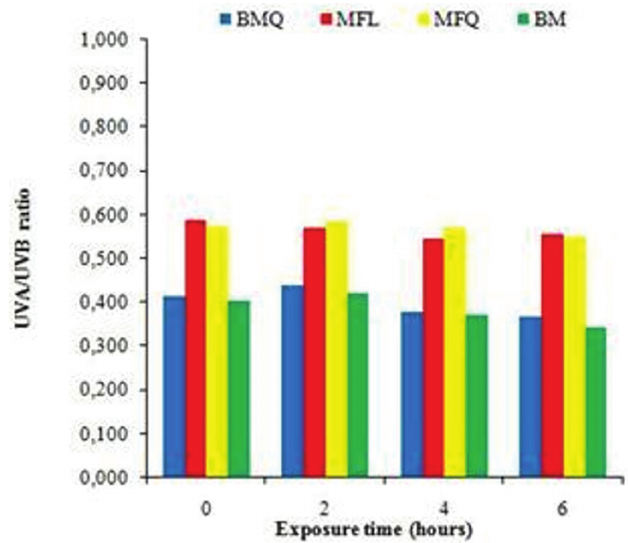
FIGURE 4 - UVA/UVB ratio of MFQ, MFL, BM and BMQ formulations after six hours of sun exposure. The results were expressed as mean ± DP, with n = 3.0. Abbreviation: MFQ - formulation containing octyl-p-methoxycinnamate (OMC), benzophenone-3 (BP-3), ethylhexylmethoxycrylene (EHMCR) and keratin; MFL - formulation containing OMC, BP-3 and EHMCR; BM - formulation containing OMC and BP-3; BMQ - formulation containing OMC, BP-3 and keratin.